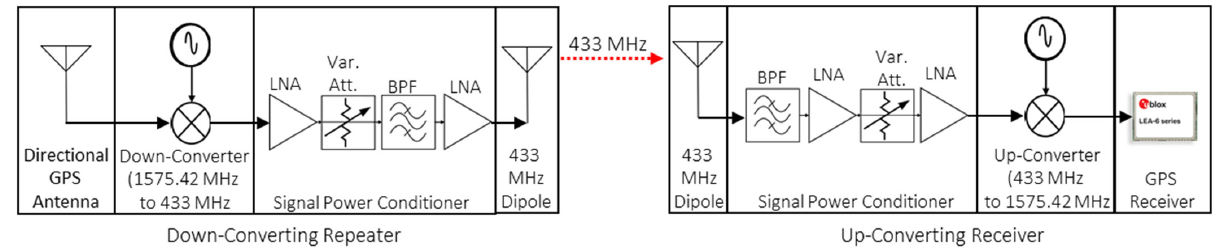
Figure 3. RF blocks in down-converting repeater ( left ) and up-converting receiver ( right ).